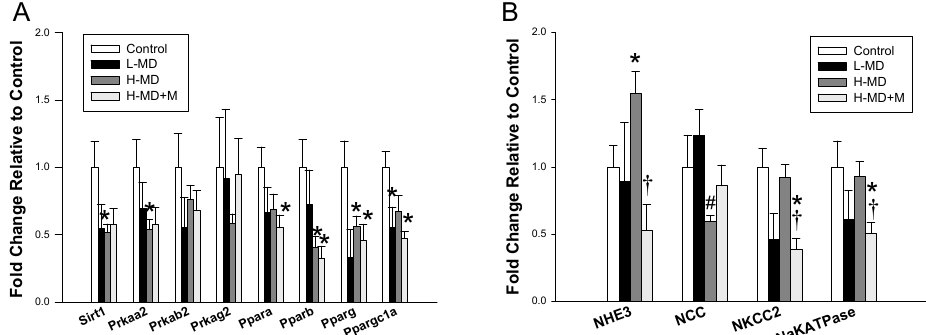
Figure 3. Effects of a maternal methyl-deficient diet (L-MD), high methyl-donor diet (H-MD), and high methyl-donor diet plus melatonin therapy (H-MD+M) on mRNA expression of ( A ) nutrient-sensing signals and ( B ) sodium transporters in male offspring kidneys at 12 weeks of age. * p < 0.05 vs. control; # p < 0.05 vs. L-MD; † p < 0.05 vs. H-MD. Data are mean ± SEM, n = 7–8/group.